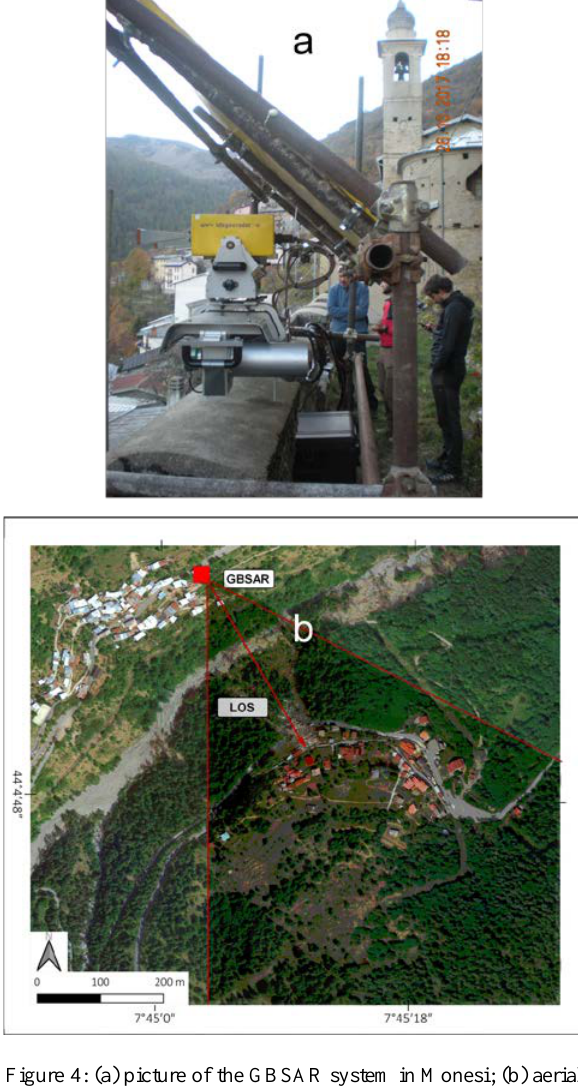
Figure 4: (a) picture of the GBSAR system in Monesi; (b) aerial view of the area of Monesi di Mendatica landslide with indicated the radar location, LOS direction and rough extension of the radar Field Of View